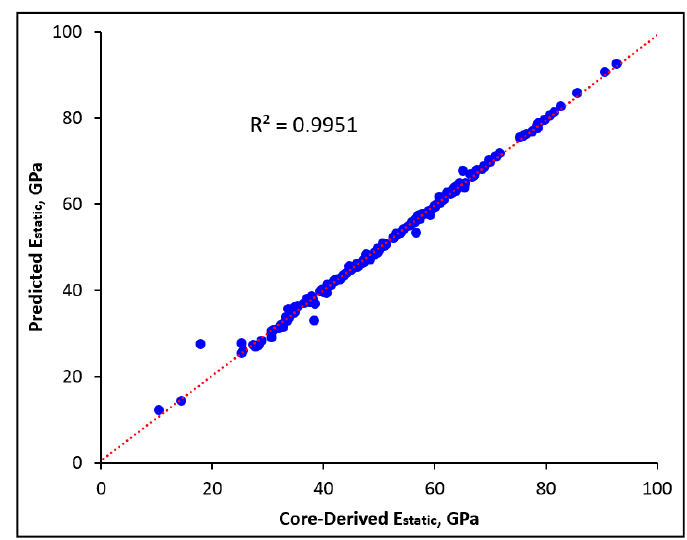
Figure 6. Cross-plot of the core-derived and predicted E static of the testing dataset.